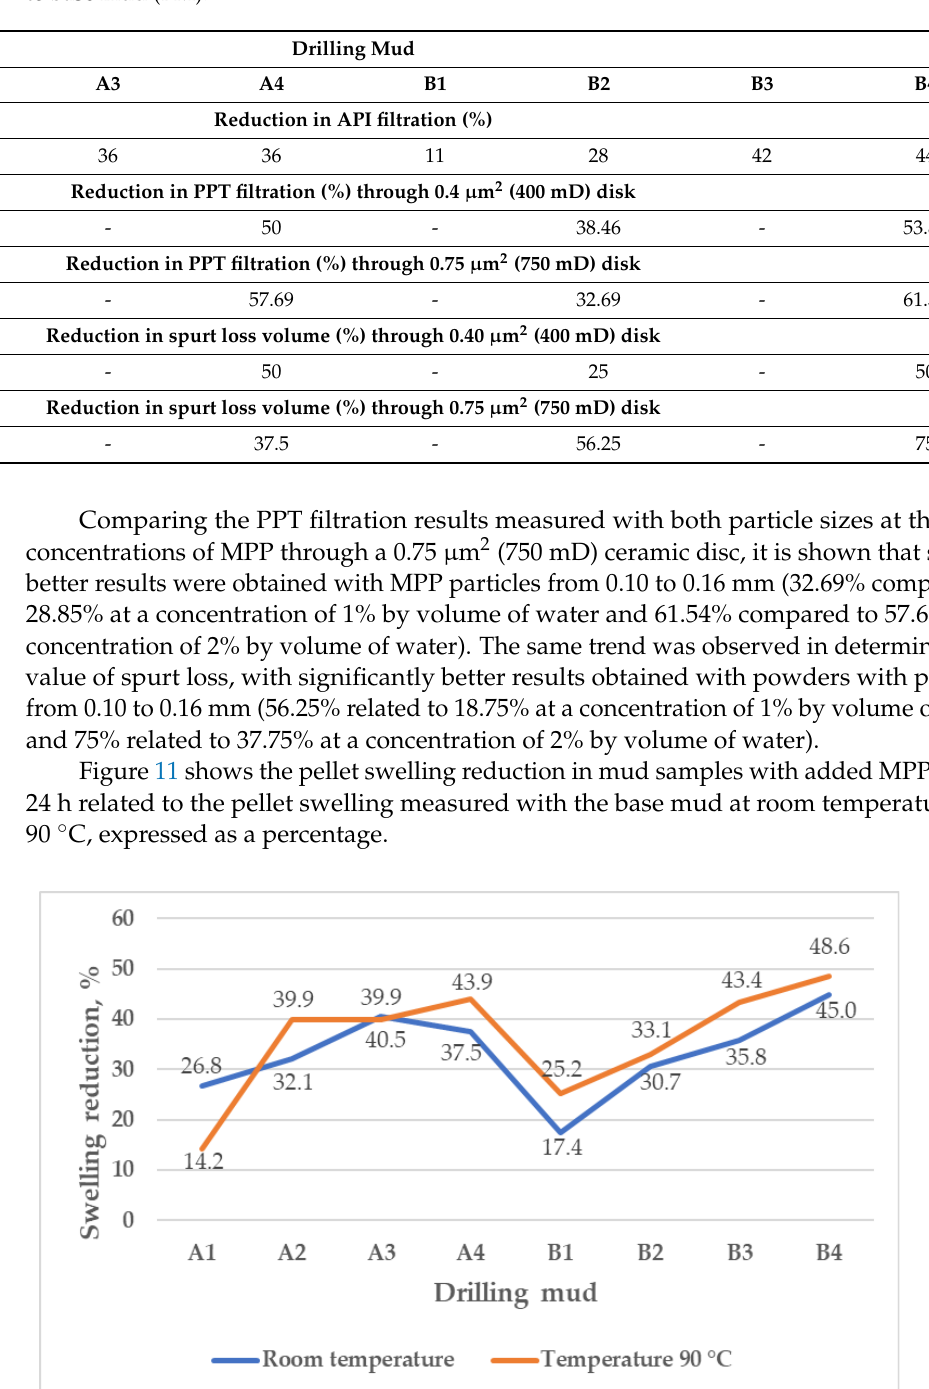
Table 5. Decrease in API filtration, PPT filtration, and spurt loss for all tested mud samples in regard to base mud (BM).